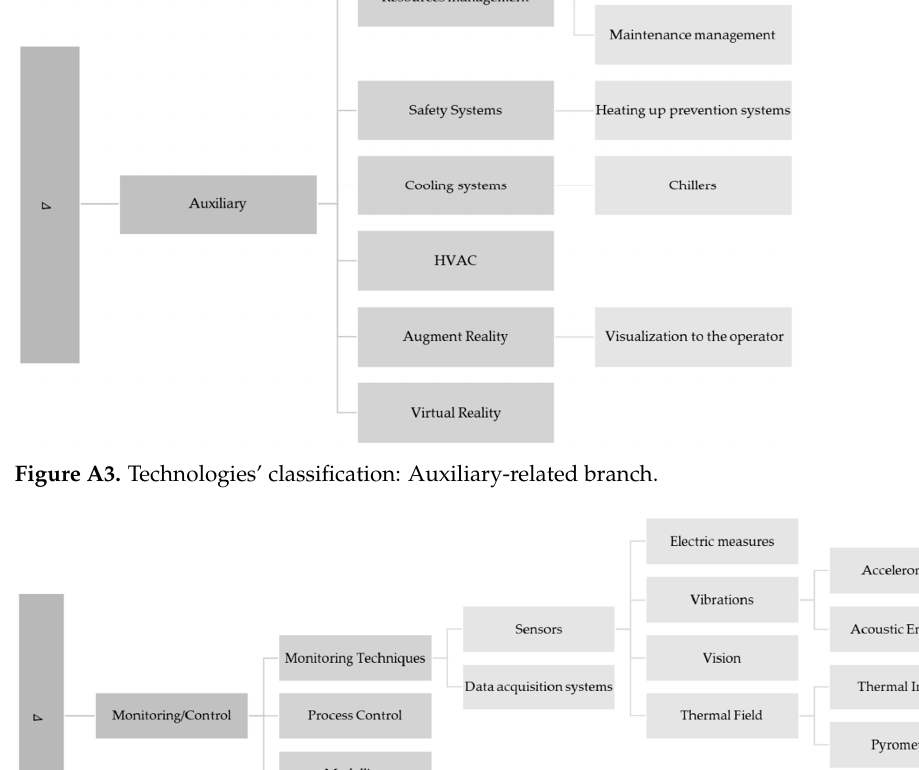
Figure A4. Technologies’ classification: Monitoring/Control-related branch.